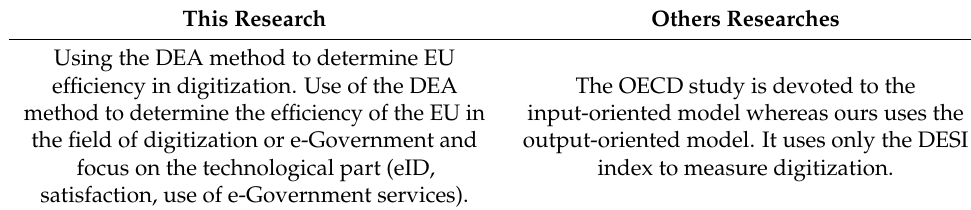
Table 15. Comparison of the research with other studies. This Research Others Researches Using the DEA method to determine EU efficiency in digitization. Use of the DEA The OECD study is devoted to the input-oriented model whereas ours uses the method to determine the efficiency of the EU in output-oriented model. It uses only the DESI the field of digitization or e-Government and index to measure digitization. focus on the technological part (eID, satisfaction, use of e-Government services). Use of CCR, BCC models Use of the SBM model and CCR model. Use and identification of different indices in the field of digitization: - DESI, EGDI, DSGI, e-Government benchmark, GII, etc. Determining efficiency within the EU area Determination of efficiency using DEA within (East, West, North, South). China in the respective provinces. Identifying the use of the DEA method in different areas.